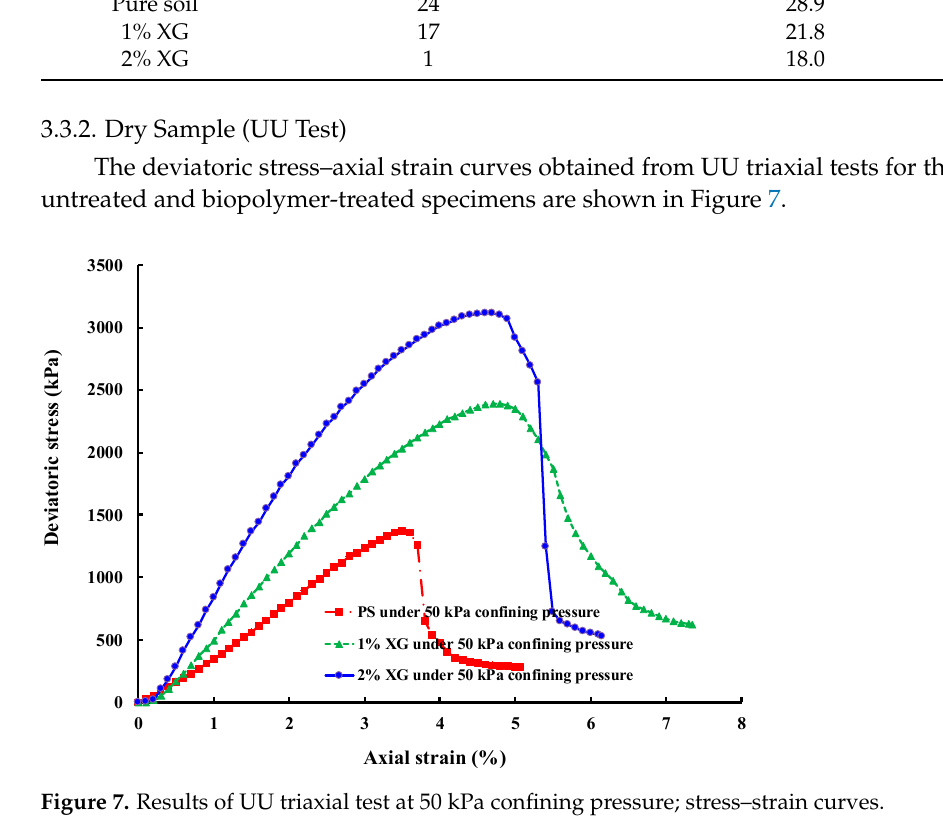
Table 2. Effective friction angle and cohesion of pure soil and XG-treated soil. Soil Reference